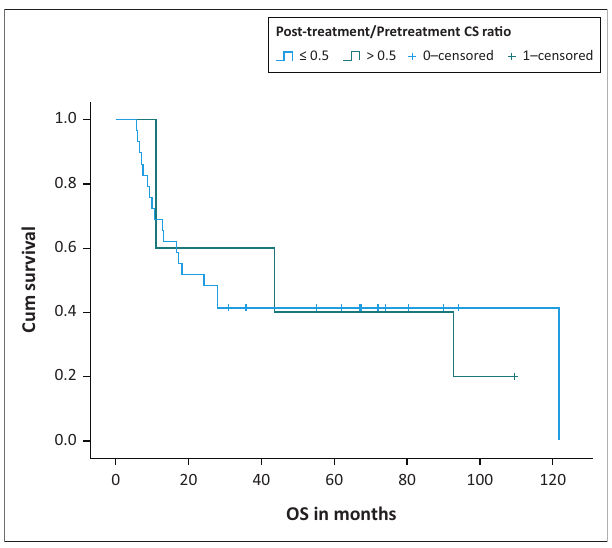
CS, Curie score; OS, overall survival. FIGURE 3: Overall survival by relative Curie score for score ≤ 0.5 versus > 0.5 at the end of treatment